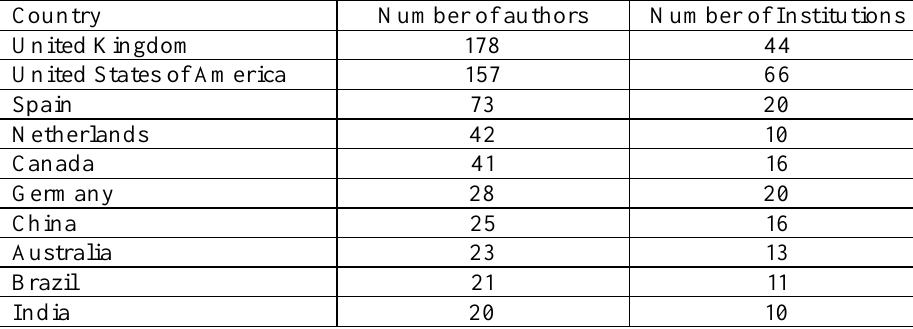
The red points on the map show that the largest concentration of authors publishing about OER are from North America (specifically from the United States of America and Canada) and Europe (specifically, from the United Kingdom, Spain, Netherlands and Germany). Table 6 shows the number of authors by